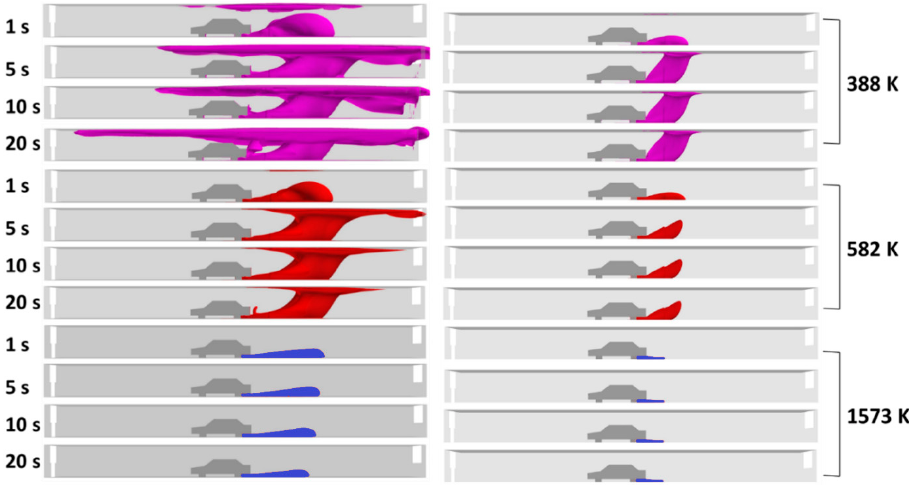
Figure 17. Side view iso-surfaces showing pain (388 K), fatality (582 K) temperature limits and visible flame temperature (1573 K) for case 6 with TPRD = 2 mm ( left ) and case 11 with TPRD = 0.5 mm ( right ).